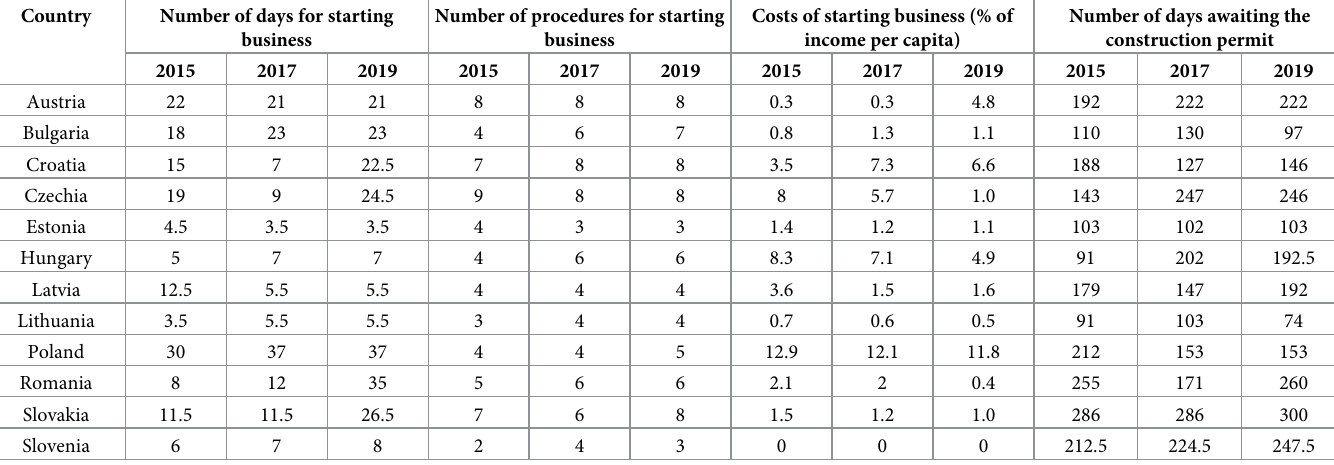
Table 5. Analysed conditions for doing business in 3SI countries. Country Number of days for starting business